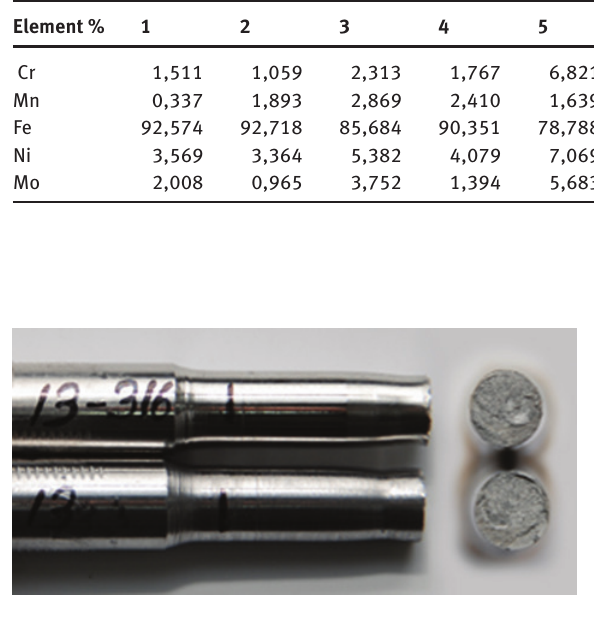
Fig. 9: The macroscopic view of tensile tested sample